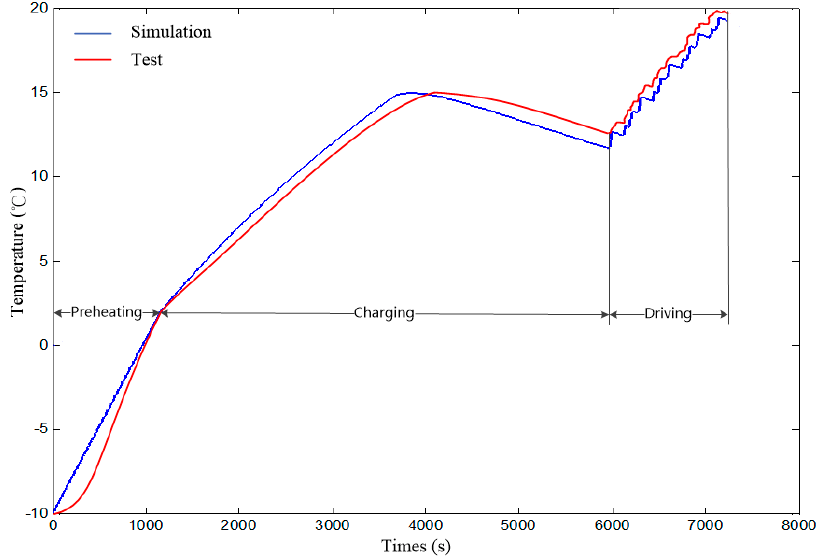
Figure 19. Battery temperature curve during Test 2.